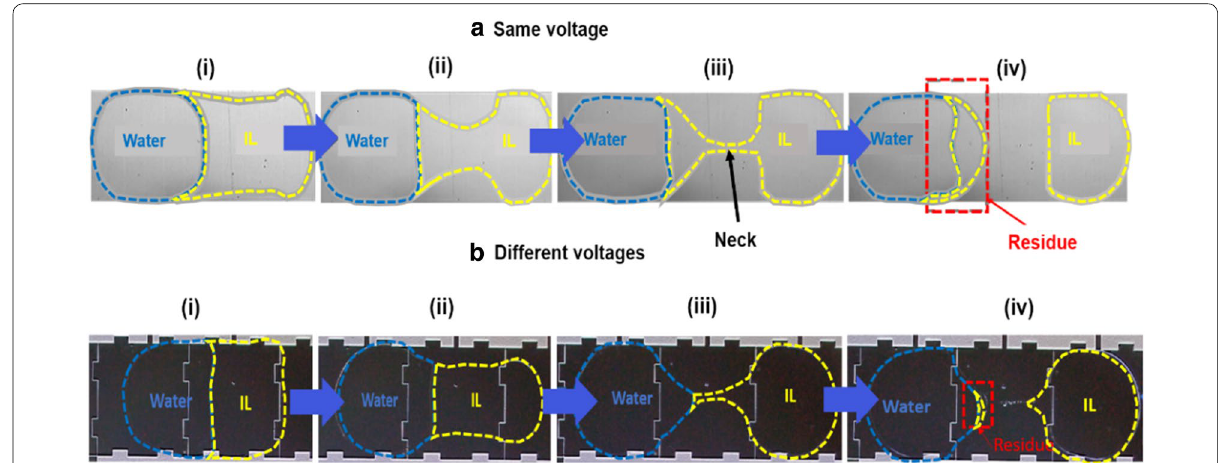
Fig. 5 Droplet profiles at different stage during phase separation using: a same voltage of 110 V on both phases, and b 130 V on water and 110 V on ionic liquid, respectively